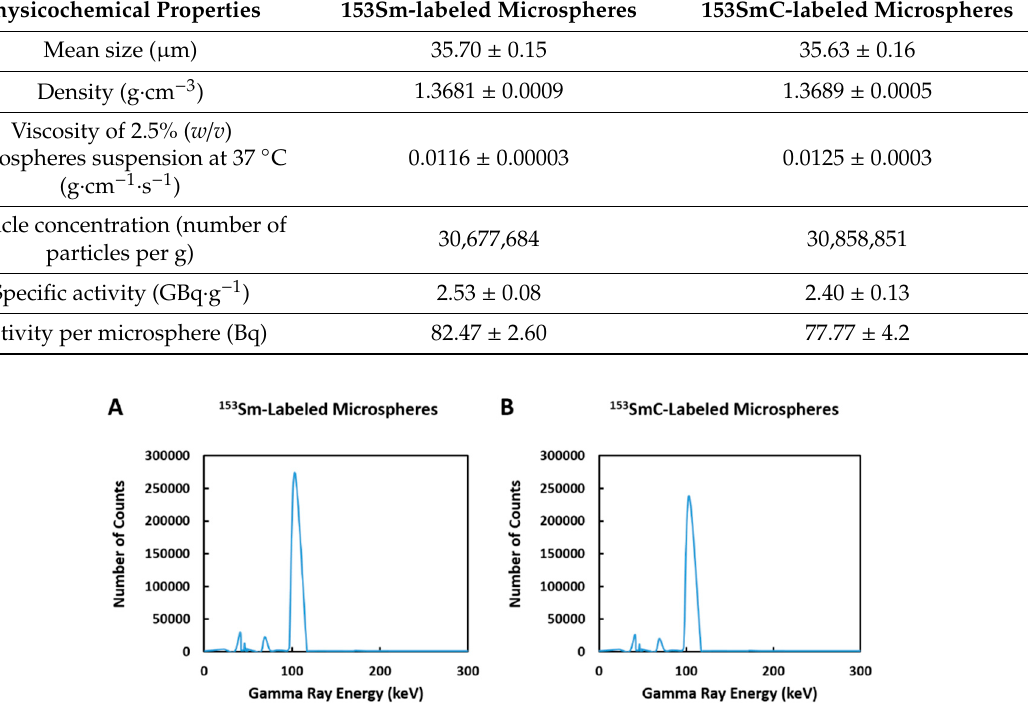
Figure 3. Scanning electron images of the Sm- and SmC-labeled microspheres both before ( A , B ) and after ( C , D ) 6 h neutron activation. The insets in the panels show the smooth surface morphology of the Sm- and SmC-labeled microspheres both before and after 6 h neutron activation, scale bar at the right bottom represent 200 µm.